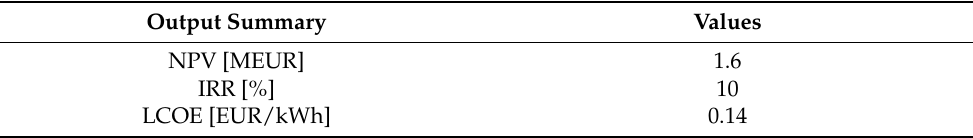
Table 11. Summary of economic assessment